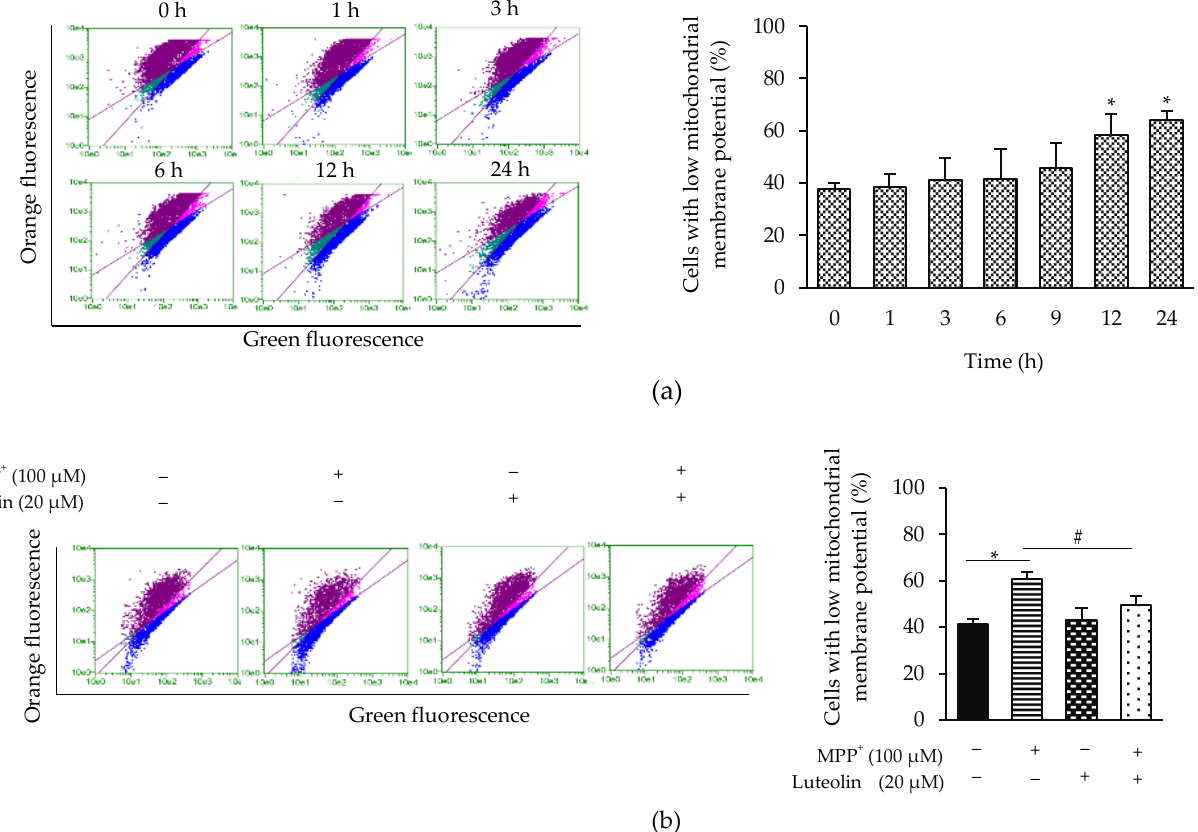
Figure 5. Luteolin protected MPP + -induced ∆ ψ m loss in SH-SY5Y cells. ( a ) Cells were incubated with 100 µ M MPP + for 0, 1, 3, 6, 9, 12 and 24 h. ( b ) Cells were pre-treated with 20 µ M luteolin for 1 h, followed by 100 µ M for 12 h. Cells were then incubated with JC-1 dye, and ∆ ψ m was determined by flow cytometry. Results presented as the mean ± SD for triplicated independent experiments. Differences are statistically significant, at * p < 0.05 versus the control group and # p < 0.05 versus the MPP + group.